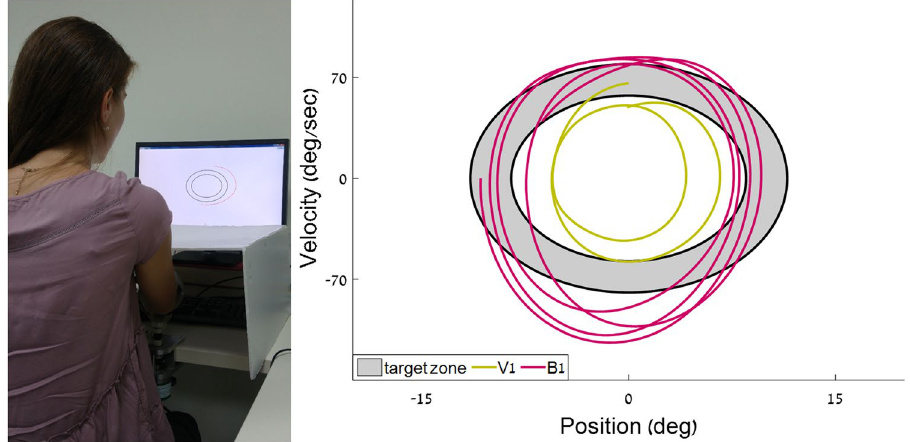
Figure 1. Left: The experimental setup. The participant places her forearm on the armrest, below an opaque cover. She uses the movements of her forearm to control a cursor on a phase plane, displayed on a computer screen. Shown here is the moment of transition between the first blind segment (B1), and the second visual segment (V2), when the red trace of her movement just reappears on the screen, and is outside the prescribed limits of the movement imposed by the black ellipses (see also supplementary video S1). Right: an excerpt from the movement traces of an older participant in the current experiment. The gray zone delimited by two black lines is the target zone on the phase plane, within which participants are asked to keep the cursor (during the actual experiment, the area between the two black ellipses was white – shown here in gray for clarity). The olive line shows the movement trace during a portion of this participant’s V1 segment, and the magenta line shows the movement trace during a portion of this participant’s B1 segment. It demonstrates the increase in both speed and amplitude during the blind segments, compared to the visually guided ones.